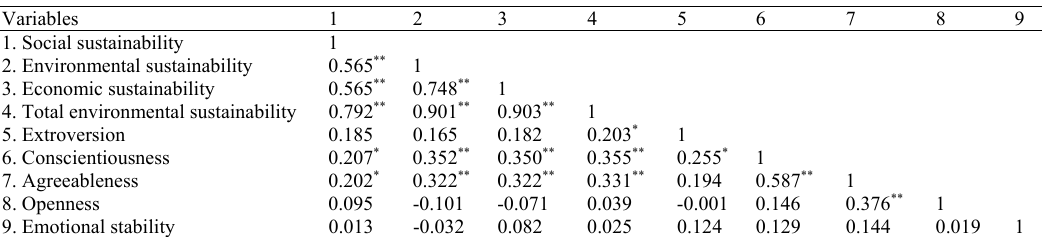
Table 3: Correlation analyses of environmental sustainability and personality Variables